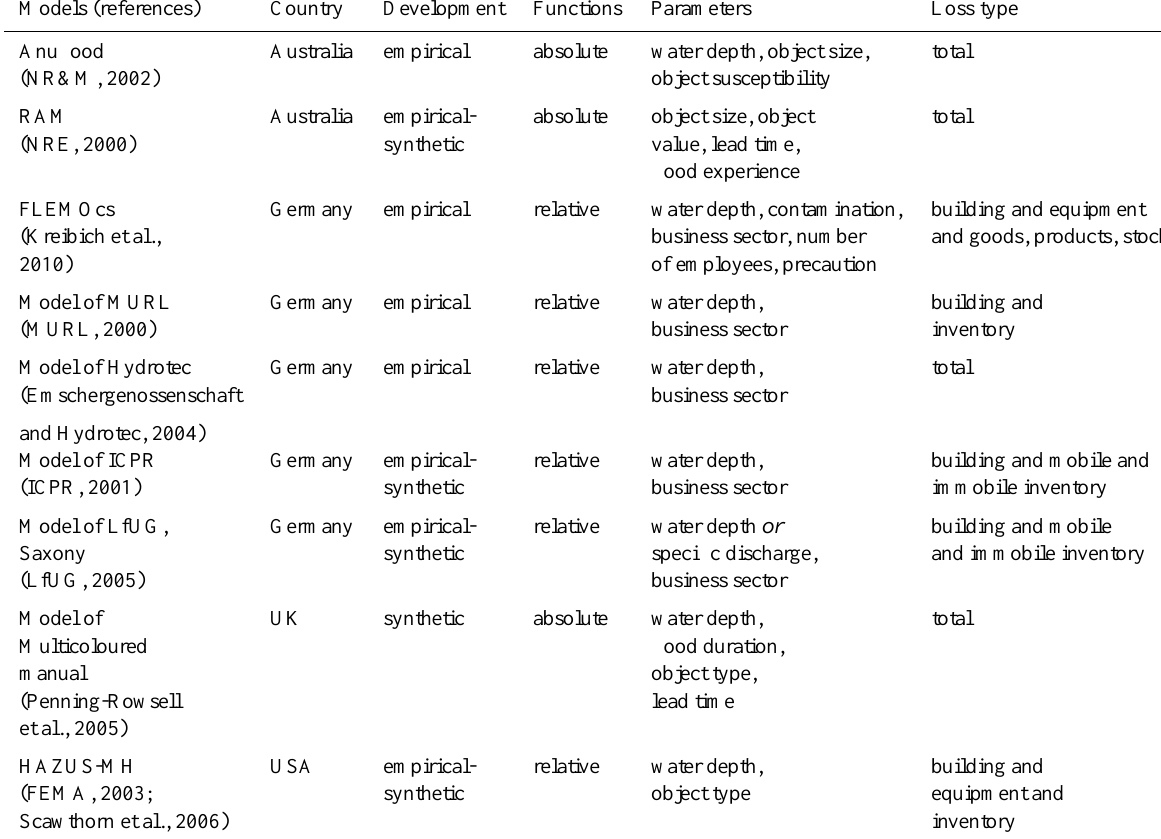
Table 7. Comparison of different damage models for the industrial sector (adapted from Kreibich et al.,